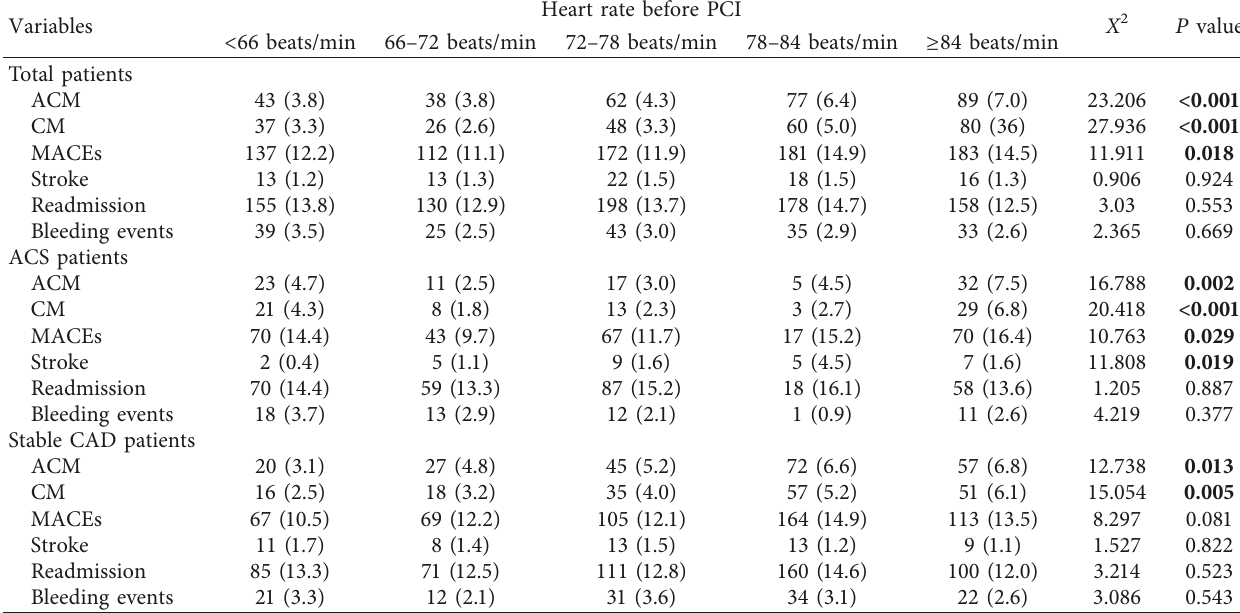
Table 2: Clinical outcomes and heart rates according to